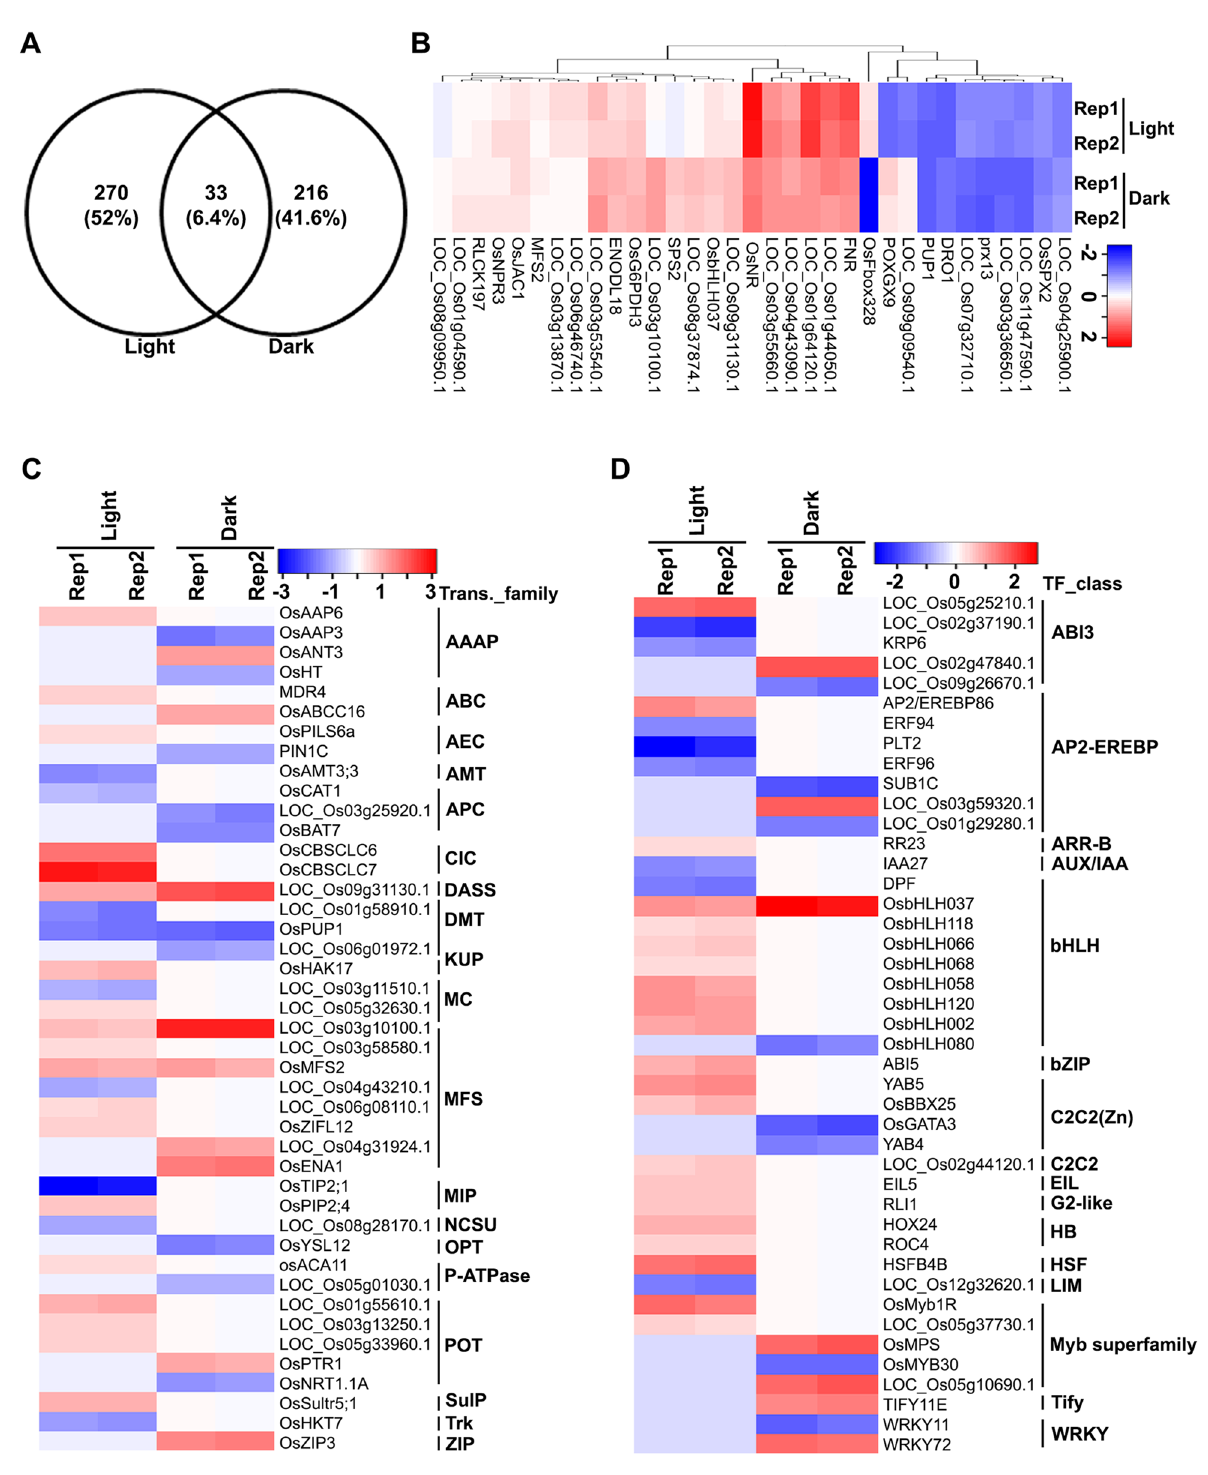
Figure 6. Transcriptomic analyses reveals common and distinct nitrate regulation by transporters and transcription factors in light and dark. ( A ) Venn diagram showing the number of common and exclusive DEGs identified in light and dark conditions. Heat map depicting the expression profile of common DEGs ( B ), transporters ( C ) and transcriptions factors ( D ). Each row represents individual nitrate-responsive gene and the columns correspond to light and dark conditions. The colour on scale bar matches the fold change value (log 2 FC) of DEGs calculated as z-scores. Heat maps were generated using heatmapper (https ://heatm apper .ca/). AAAP Amino acid/auxin permease, ABC ATP-binding cassette, AEC auxin efflux carrier, Amt ammonia transporter channel, APC amino acid-polyamine-organocation, ClC chloride carrier/channel, DASS divalent anion:Na + symporter, DMT drug/metabolite transporter, KUP K + uptake permease, MC mitochondrial carrier, MFS major facilitator superfamily, MIP major intrinsic protein, NCS2 nucleobase:cation symporter-2, OPT oligopeptide transporter, P-ATPase P-type ATPase, POT proton-dependent oligopeptide transporter, SulP sulfate permease, Trk K + transporter, ZIP Zinc (Zn 2+ )-iron (Fe 2+ ) permease. The symbols of genes were according to